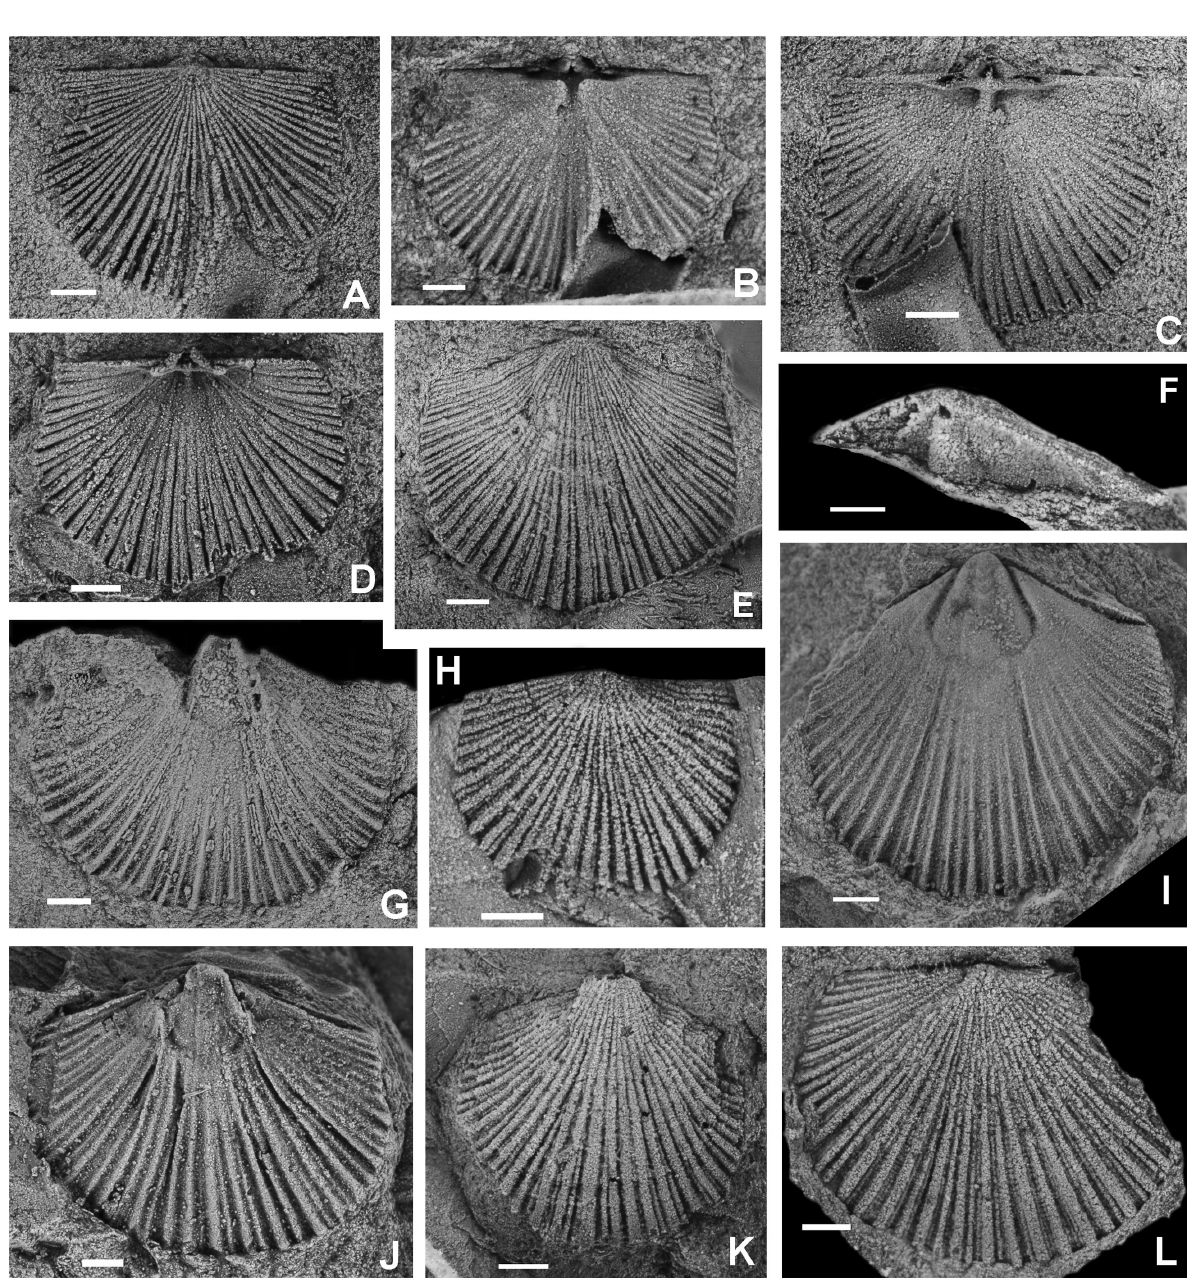
Fig. 4. Tritoechia tenuis sp. nov., Lower Ordovician, Tremadocian; A – C , NMW2012.45G.326, holotype, dorsal valve, latex cast of exterior, internal mould, latex cast of interior; D , NMW2012.45G.333, latex cast of dorsal interior; E , NMW2012.45G.324, latex cast of ventral exterior; F , NMW2012.45G.332, latex cast of ventral exterior, posterior view showing interarea and pseudodeltidium; G , NMW2012.45G.327, ventral internal mould; H , NMW2012.45G.336, latex cast of dorsal exterior; I , NMW2012.45G.329, ventral internal mould; J , NMW2012.45G.339, ventral internal mould; K , NMW2012.45G.335, latex cast of ventral exterior; L , NMW2012.45G.334, latex cast of dorsal exterior; A–C, H–L, sample MK-5/11; D–G, sample MK-5/12. All scale bars are 1